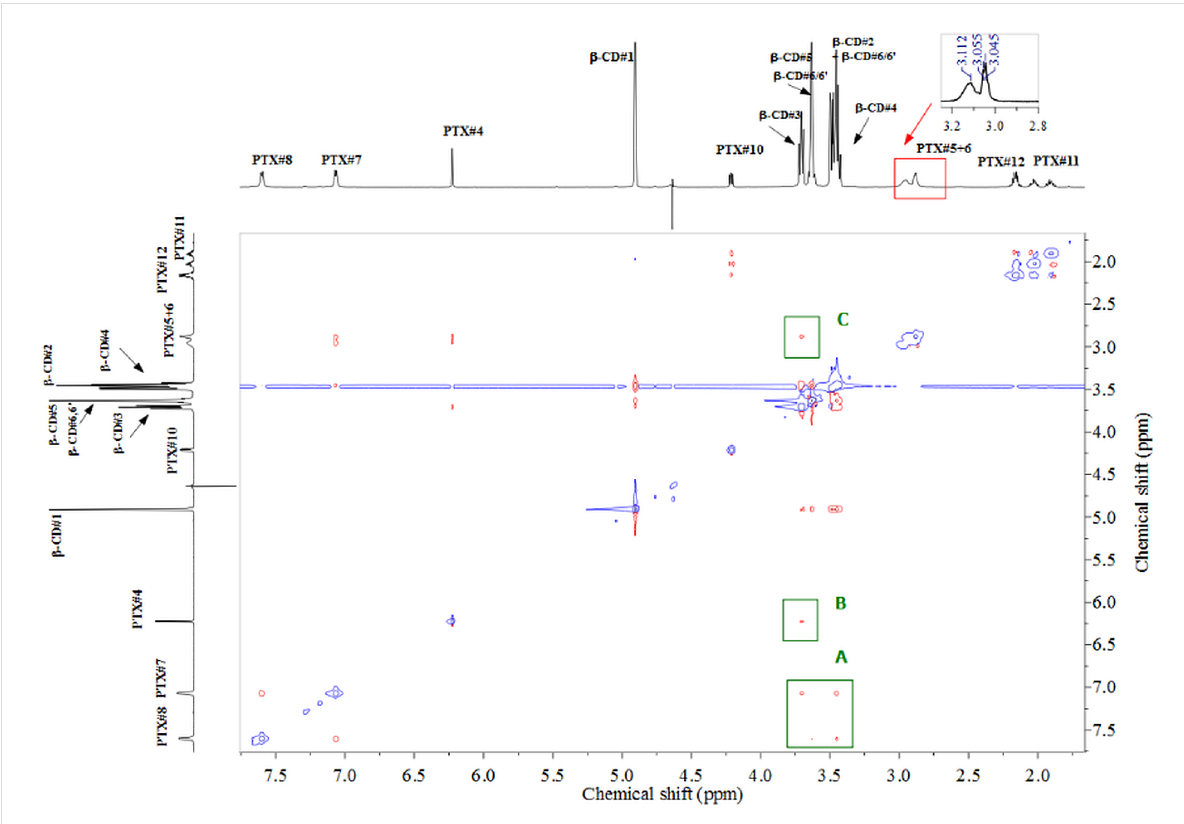
Figure 4: 2D ROESY NMR spectrum of an equimolar mixture of β -CD and PTX in D 2 O at 298 K. Inset: splitting of the bridging ethylene protons after addition of β -CD.